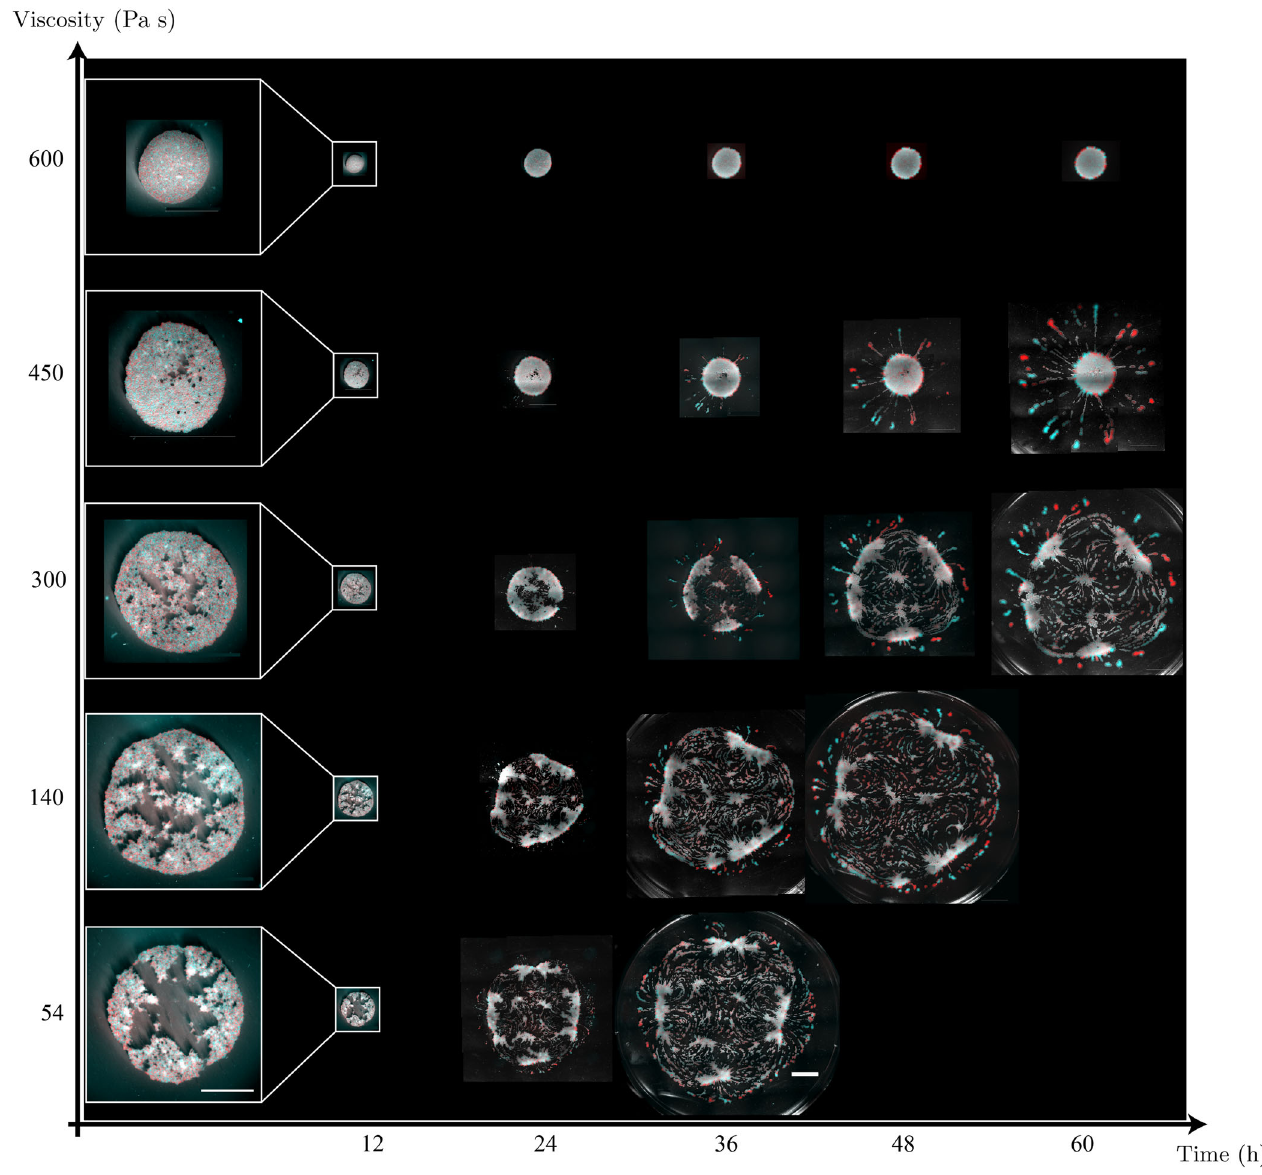
FIG. 7. Morphologies of yeast colonies growing on a liquid media substrate over time at a variety of viscosities. Quoted substrate viscosities are accurate to about 10% (see Table I). The figure shows merged bright-field and fluorescent images. White, transmitted bright field; red, YFP strains; cyan, mCherry strains. All images have the same scale, and the scale bar at the lower right corresponds to 10 mm. The left column is an enlargement of the colonies after 12 h of growth, and its scale bar corresponds to 5